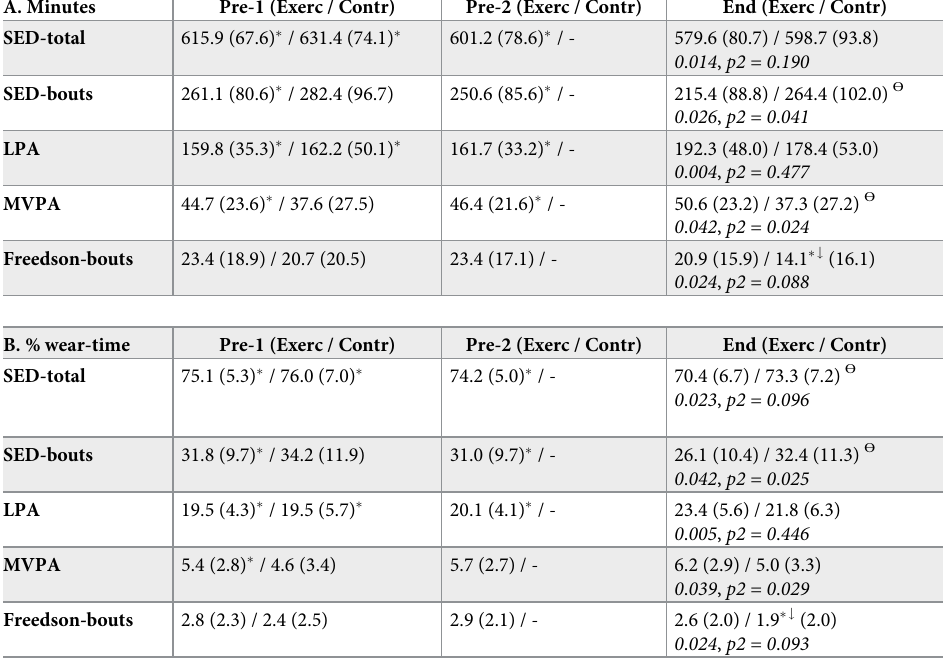
Table 3. Mean values ( ± SD) in min/day (A-above) and in %-of-wear-time (B-below) for the exercise group (Exerc) and the control group (Contr) for various accelerometer parameters. A significant difference ( p1 < 0.05) between the two groups (seen only in End) is marked with the symbol ϴ ; and between End and either of the two pre-tests (marked at each pre-test) with a star ( � ) both for the exercise group and the control group. The control group per- formed only one pre-test. The effect size (ES) of the interaction effect comparing the exercise group versus the control group over time (Pre-1-to-End), measured with partial eta-squared, with significance level ( p2- value), are presented below the End-tests´ average